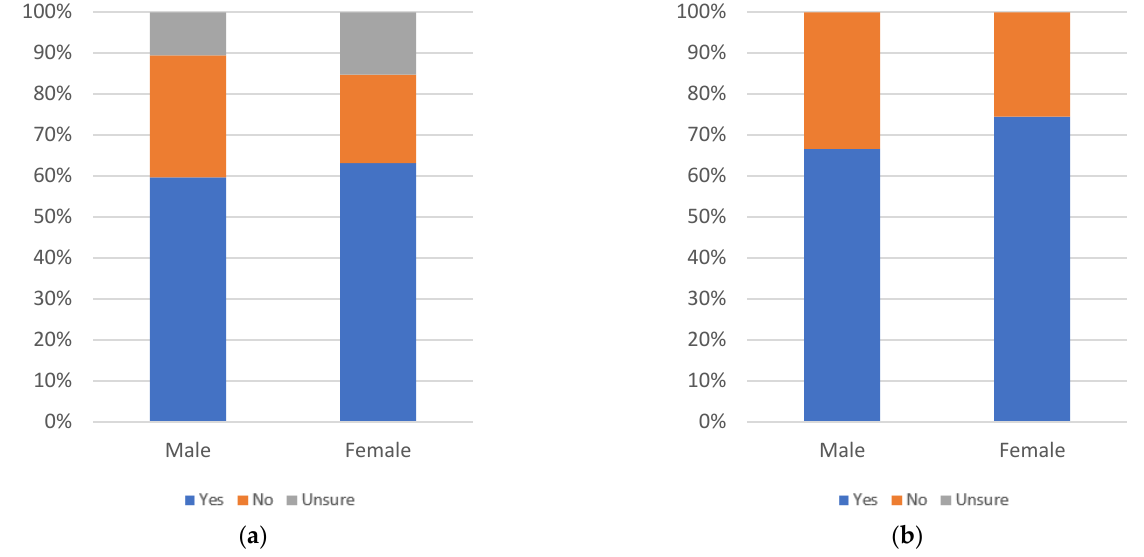
Figure 77. Label use, by gender: ( a ) with uncertain respondents (left) and ( b ) without uncertain respondents (right).